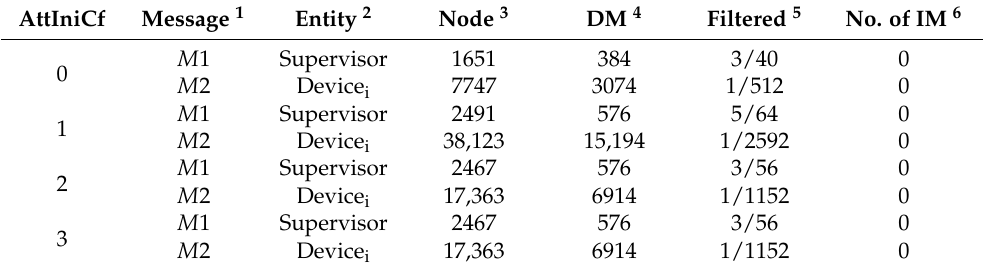
Table 4. State space search